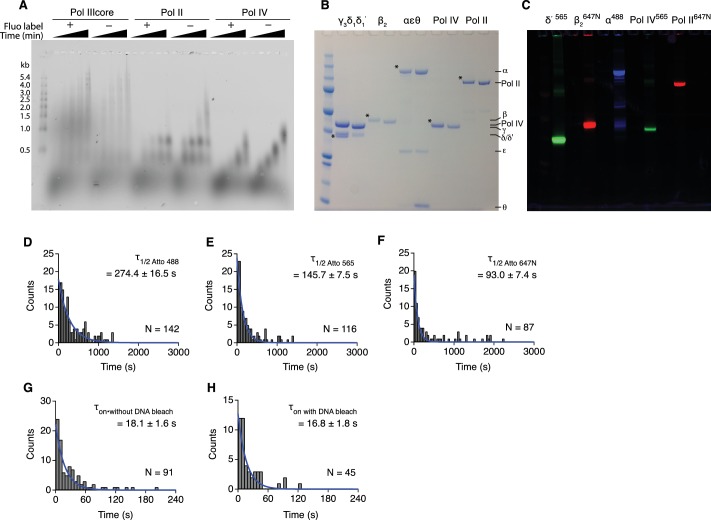
Validation of proteins, fluorophores and DNA.(A) ϕX174 phage DNA (5.4 kb) primer extension assays, showing the activity of fluorescently labeled and unlabeled proteins. In the labeled reactions, fluorescently labeled clamp, labeled clamp loader, and labeled polymerase (Pol IIIcore, Pol II, or Pol IV) were used. Reaction were quenched at 0, 0.5, 1, 2, and 5 min. The increased background in the ‘Pol IIIcore Fluo label +" lanes is caused by the presence of αAtto488, whose fluorescent signal overlaps with that of the fluorescein label on the DNA primer (B) Coomassie stained SDS-page showing unlabeled and labeled proteins (marked with *). (C) Three-wavelength fluorescent scan of the same gel shown in B (before coomassie staining) revealing the presence of the labeled proteins. (D–F) Lifetimes of fluorescent dyes Atto 488, Atto 565, and Atto 674N under experimental conditions. The dyes were attached to the β-clamp that was loaded onto the DNA substrate used in the experiments. (G–F) Lifetime of Pol IIIcore on clamp-DNA before and after photobleaching of the Atto 488 fluorophore on the DNA substrate. All values represent mean lifetime/lag time ±s.e.m.